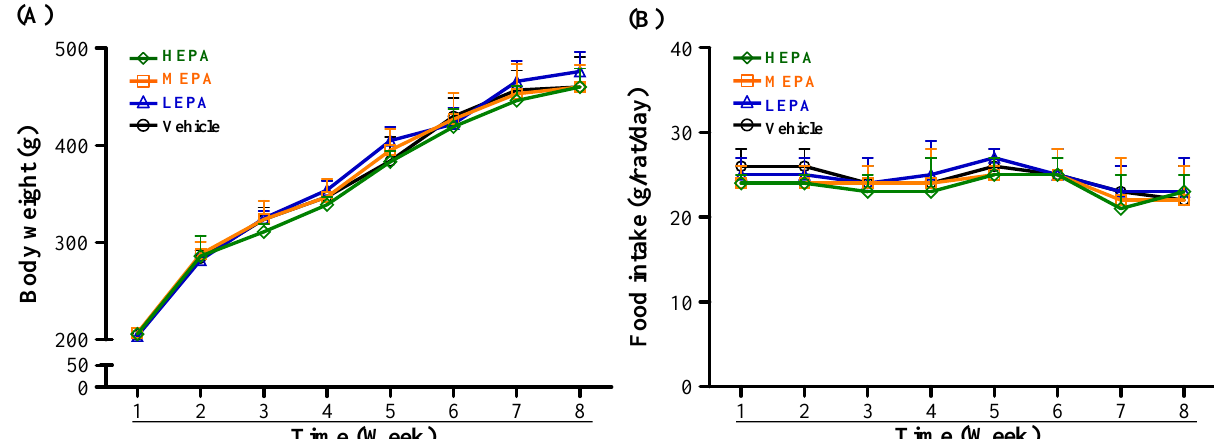
Figure 1. Effect of EPA on body weight ( A ) and daily food intake ( B ) of rats. Data are mean ± SD ( n = 6). LEPA: low dose (75 mg/kg); MEPA: medium dose (150 mg/kg); HEPA: high dose (375